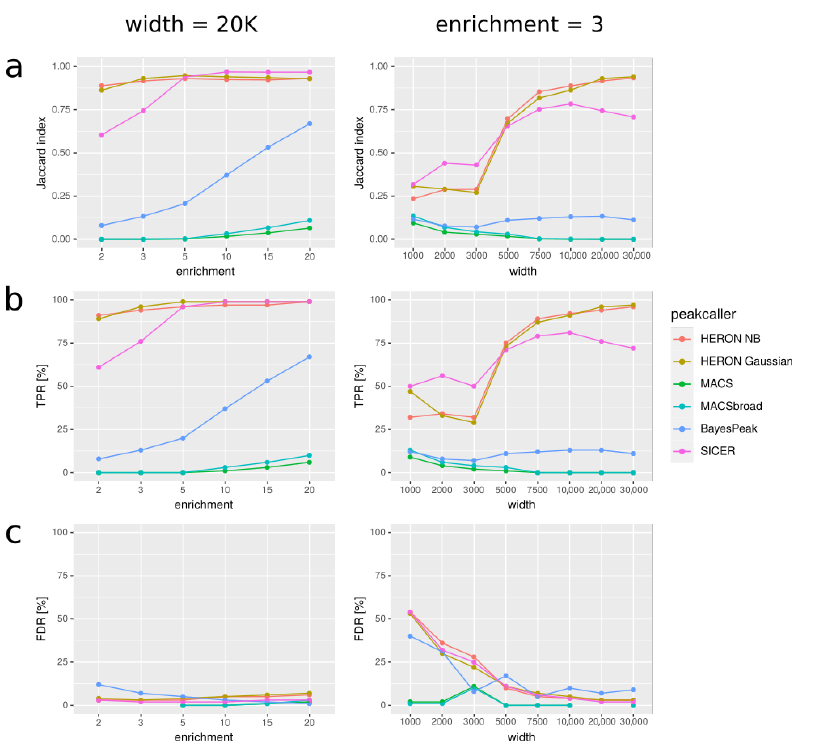
Figure 3. Comparison of peakcallers on simulated data for two different settings. In the first column, all the simulated peaks are 20K bp long, and simulated average enrichment varies. In the second column, average enrichment on peaks is constant and equal 3, and the peak length varies. In the rows, three measures are shown: ( a ) Jaccard index: |predicted * real| / |predicted + real|, ( b ) TPR: |predicted * real| / |real|, and ( c ) FDR: |predicted \ real| / |predicted|; where: |predicted|— summaric size of regions predicted as peaks; |real|—summaric size of real peaks, i.e., simulated ones that we wanted to discover; A*B—intersection; A+B—union; A \ B—difference (A and not B). “HERON NB” means HERON with negative binomial